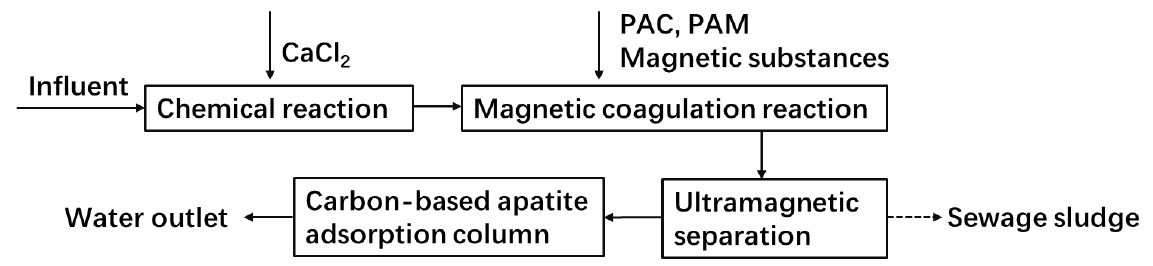
Figure 6. Flow chart of ultra−magnetic separation– adsorption process.